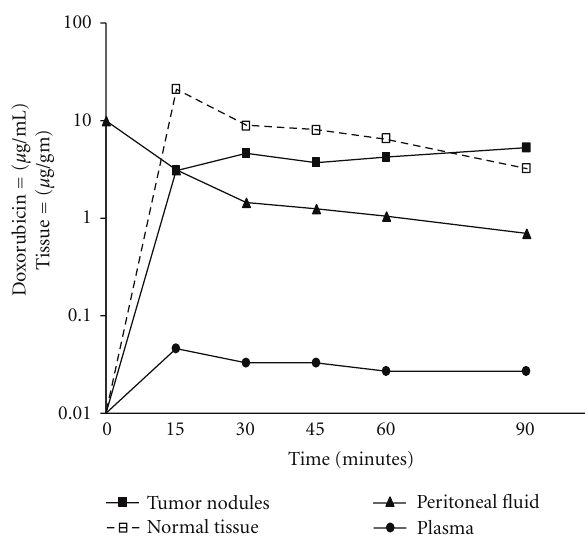
Figure 2: Doxorubicin concentration in plasma, peritoneal fluid, tumor nodules, and normal adjacent tissues [32].